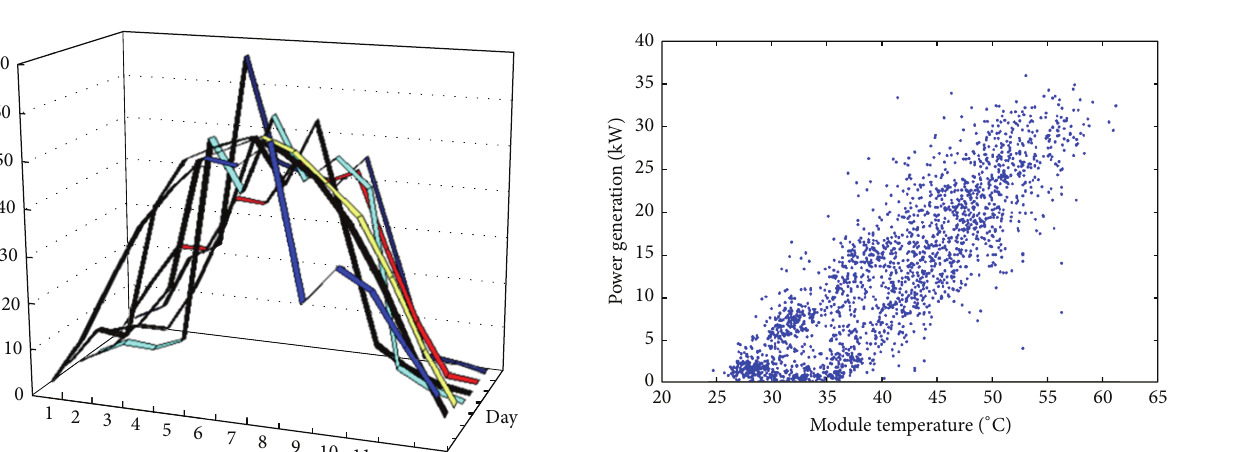
Figure 4: Correlation analysis of power output with respect to module temperature at the PTM Green Energy Office (GEO).